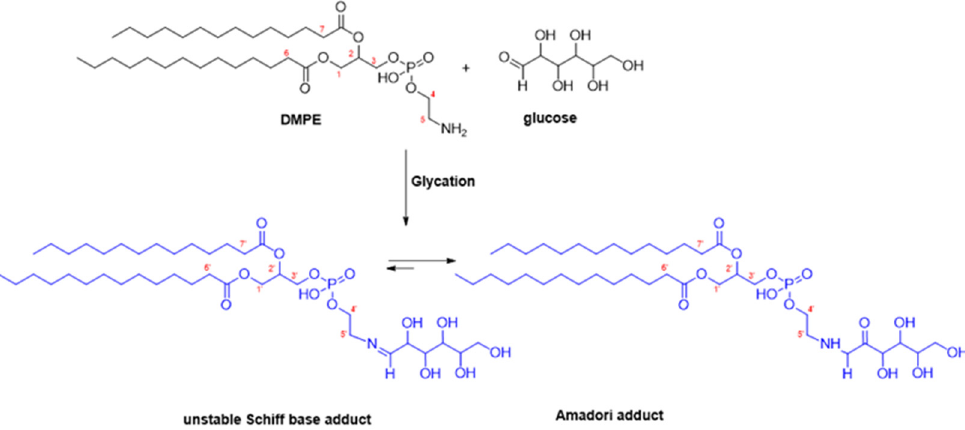
Figure 1. Structural characterisation of DMPE-glycated adduct in the reaction mixture by electrospray mass spectrometry (ESI-MS) in the (+)ve ion mode ( A ) and inset showing the zoom scan of molecular ion ( m/z 798.4), tandem mass spectrometry (ESI-MS/MS) of the precursor ion at m / z 798.6 ( B ), magnified 1 H NMR (region 3.10 to 4.4 ppm) ( C ), and two-dimensional 1 H/ 1 H (COSY) spectrum ( D ).